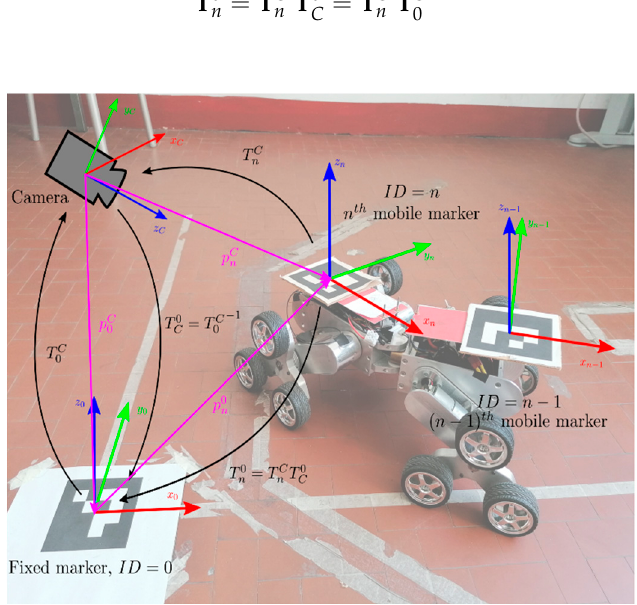
Figure 5. Graphical representation of the relations between reference frames of the camera, the fixed reference and the generic n th marker and the corresponding homogeneous transformations. Algorithm 2: Improved Automatic marker detection and localization algorithm while Frame of the video is available